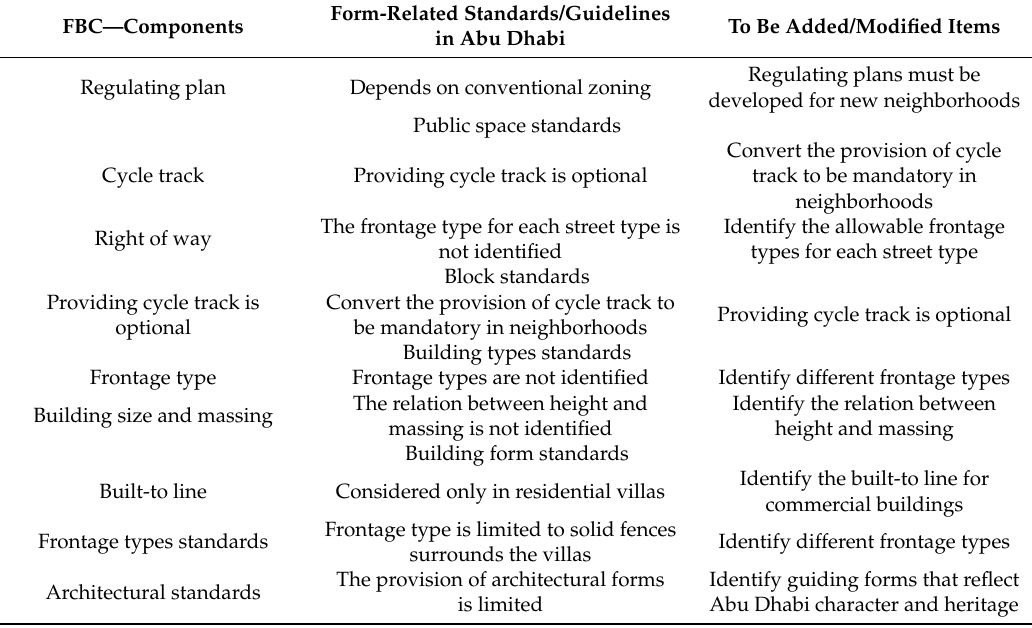
Table 3. The added/modified items to the proposed localized FBC framework for new urban neighborhoods in Abu